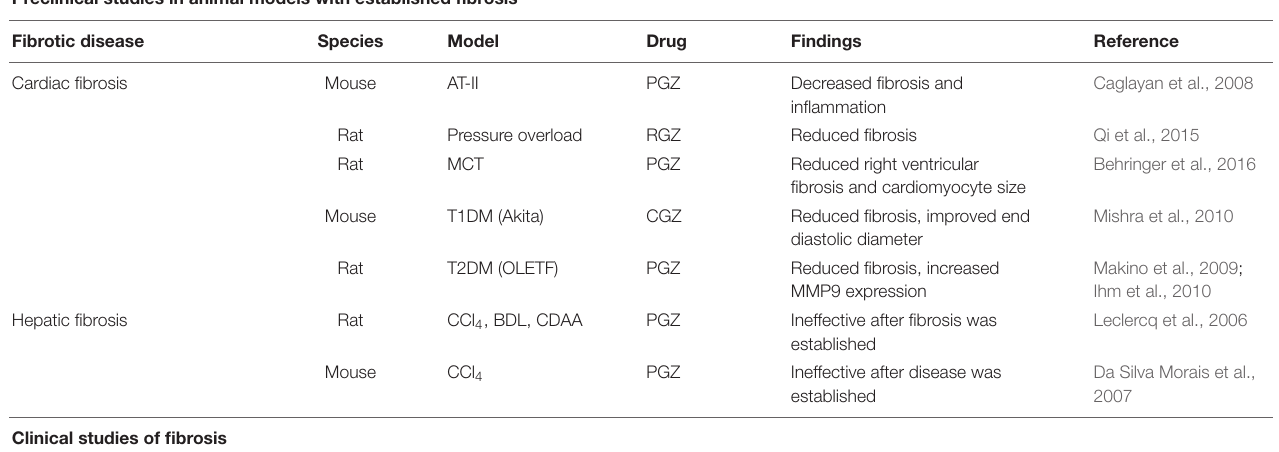
Preclinical studies in animal models with established fibrosis Fibrotic